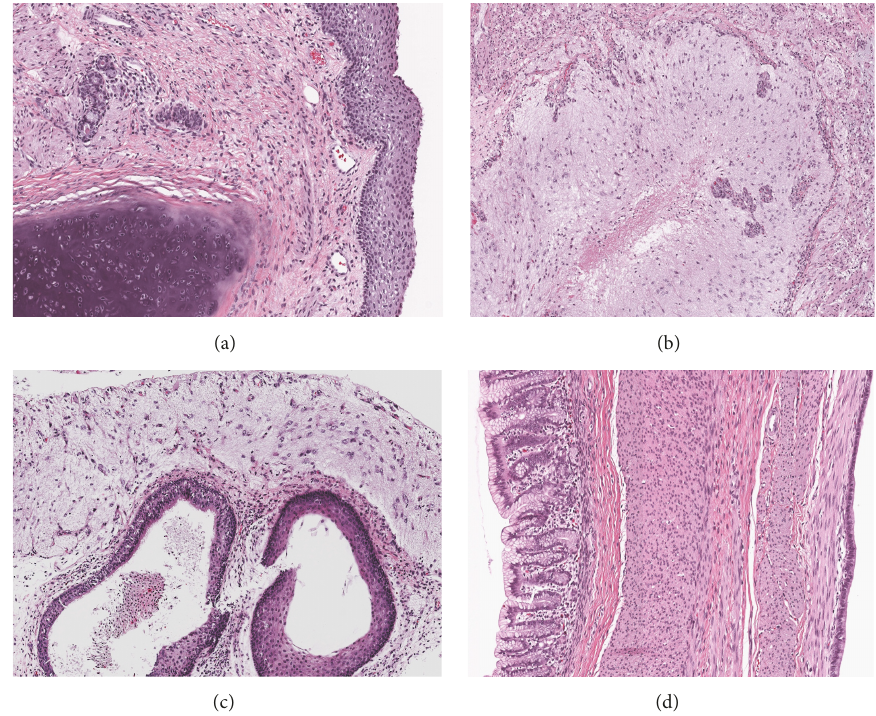
Figure 4: Histology of multiple pelvic lesions following repeat laparotomy demonstrated neoplasms composed of derivatives of all three germ layers, namely, ectoderm, mesoderm, and endoderm consistent with mature teratoma. (a) Mature cartilage and squamous epithelium (H&E × 100). (b) Mature neuroglia and vascular proliferation (H&E × 200). (c) Cysts lined with mature squamous and ciliated columnar respiratory epithelium and overlying mature neuroglia (H&E × 200). (d) Large cyst wall with gastric mucinous epithelium, bundles of smooth muscle, and adjacent cysts lining of the ciliated respiratory epithelium (H&E ×